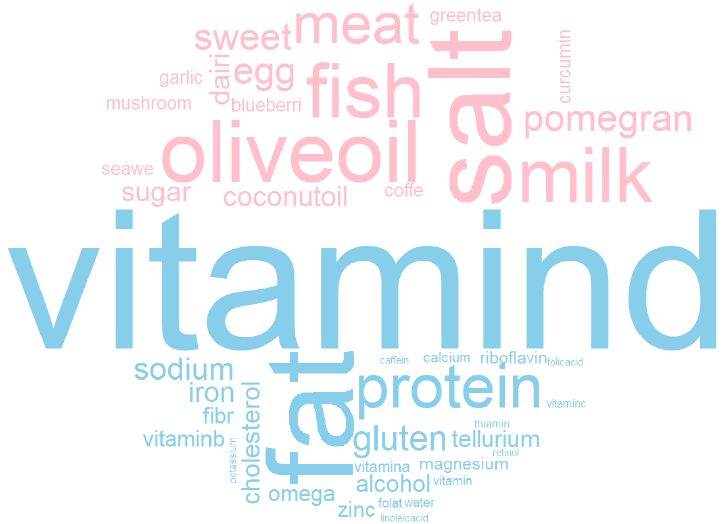
Figure 5. The word cloud of the most investigated foods and nutrients in studies on diet and MS. Words in pink represent most frequently appearing foods, and words in blue represent most frequently appearing nutrients in titles of all articles exported from the Web of Science Core Collection Database. More frequently appeared words are displayed with bigger font sizes.